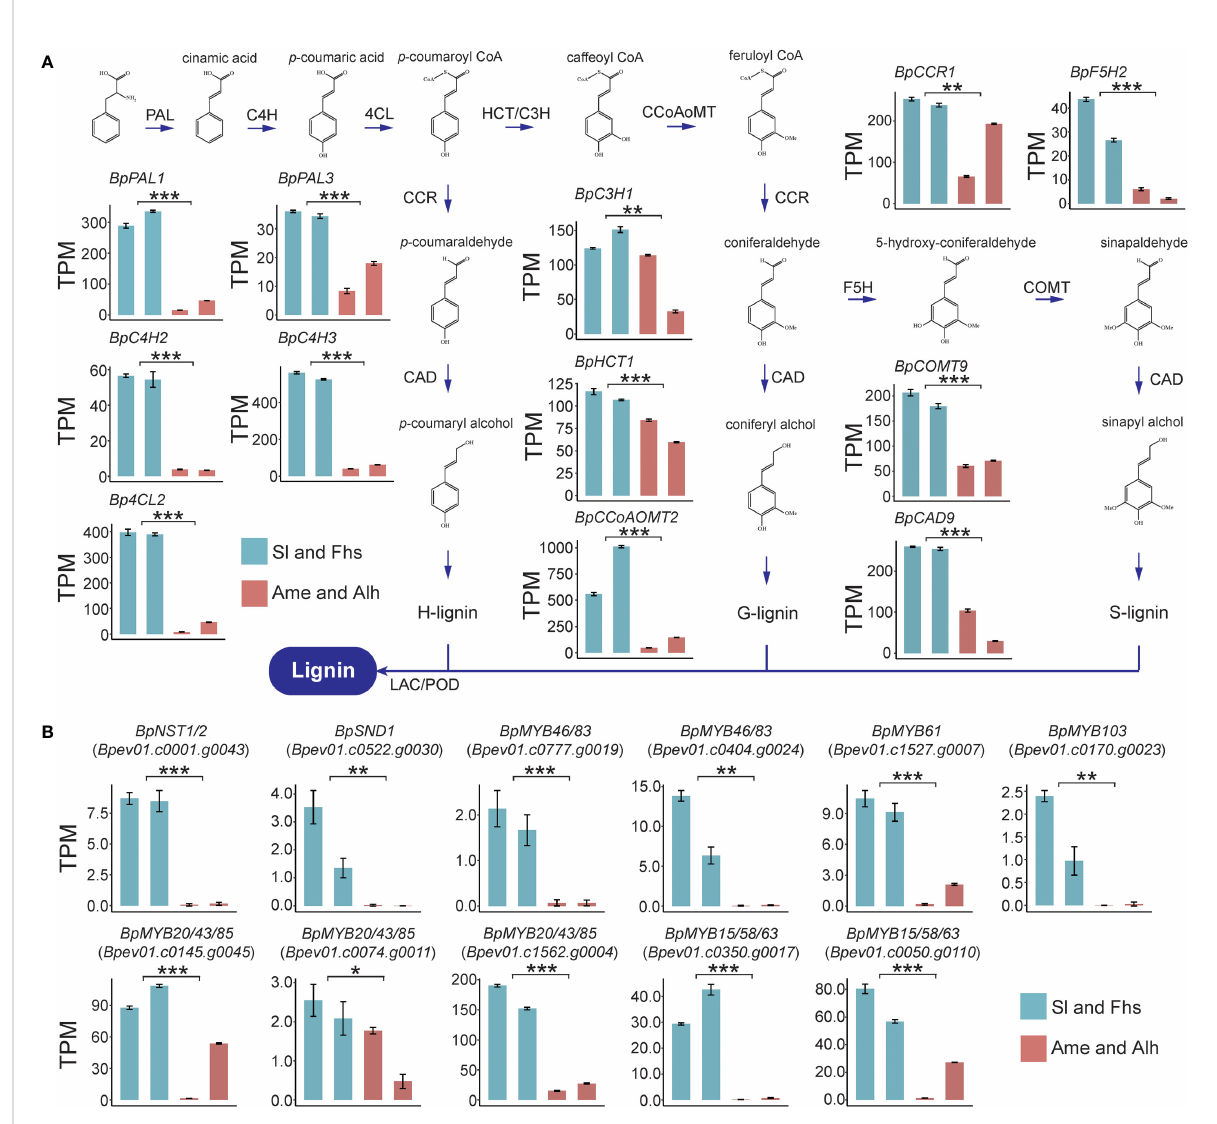
FIGURE 2 Expression pro fi les of lignin biosynthesis genes (A) and TFs (B) in Sl, Fhs, Ame, and Alh. Transcriptome levels for 12 lignin biosynthesis genes and 11 TFs were normalized to TPM (Transcripts Per Million). Colors represent the groups of birch trees (Sl and Fhs in green, and Ame and Alh in red). The t -test was used to evaluate the difference in gene expression between Sl, Fhs and Ame, Alh. The p ≤ 0.05 is marked as ‘ * ’ , p ≤ 0.01 is marked as ‘ ** ’ , p ≤ 0.001 is marked as ‘ *** ’